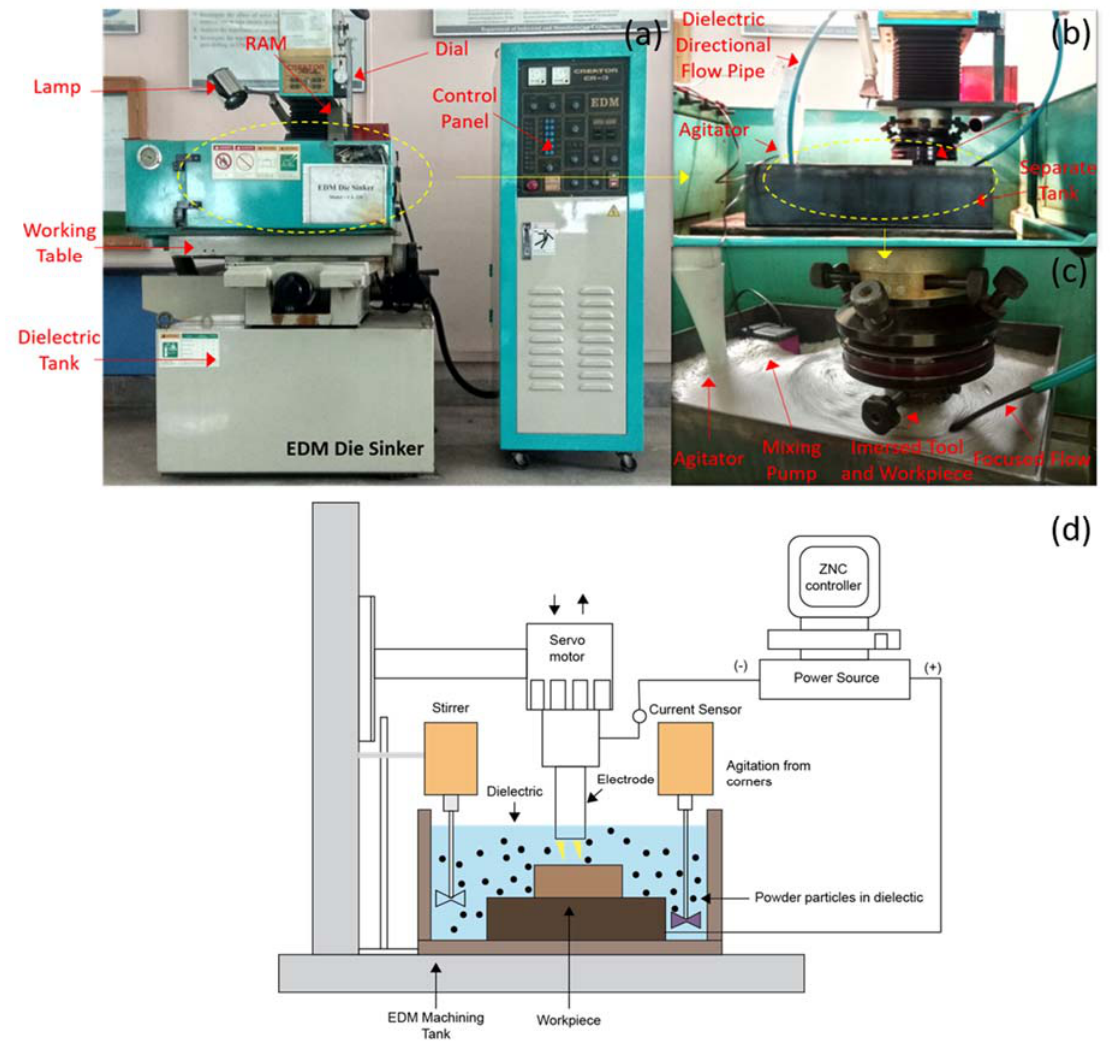
Figure 1. Experimental setup and schematic: ( a ) EDM setup as a whole, ( b ) closeup of machiing head, ( c ) closeup of mixing tank, and ( d ) schematic of powder mixed electric discharge